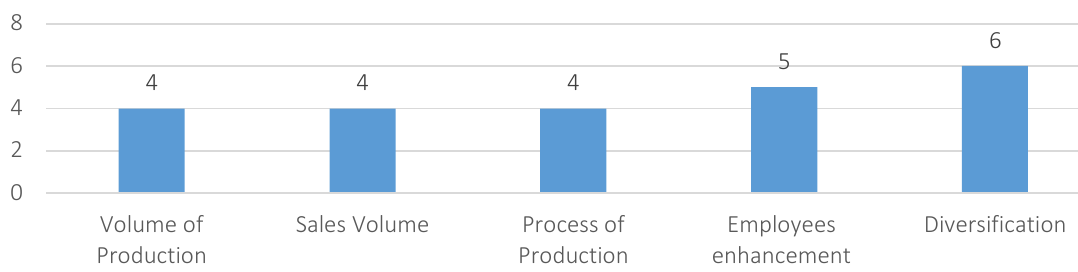
Figure 1. Relationship between the dependent variables and the number of repetitions in previous